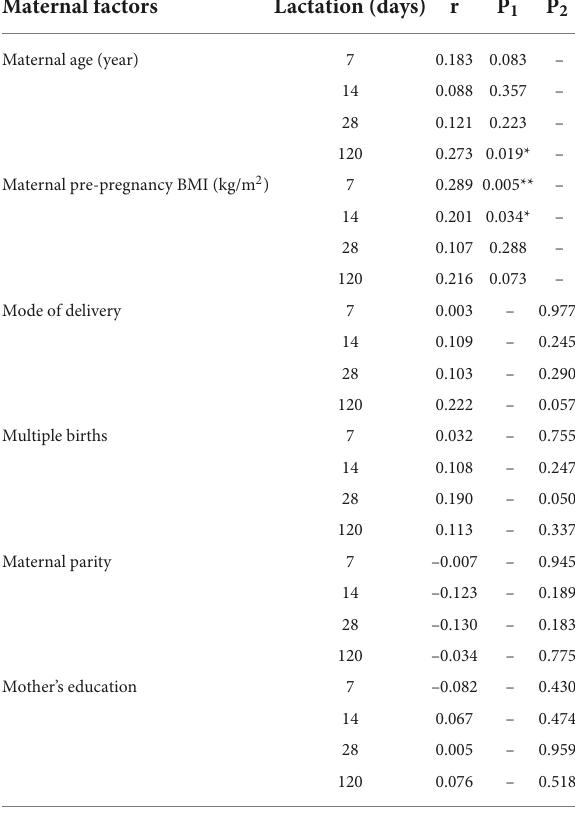
TABLE 2 Maternal factors and their correlation with milk LPN